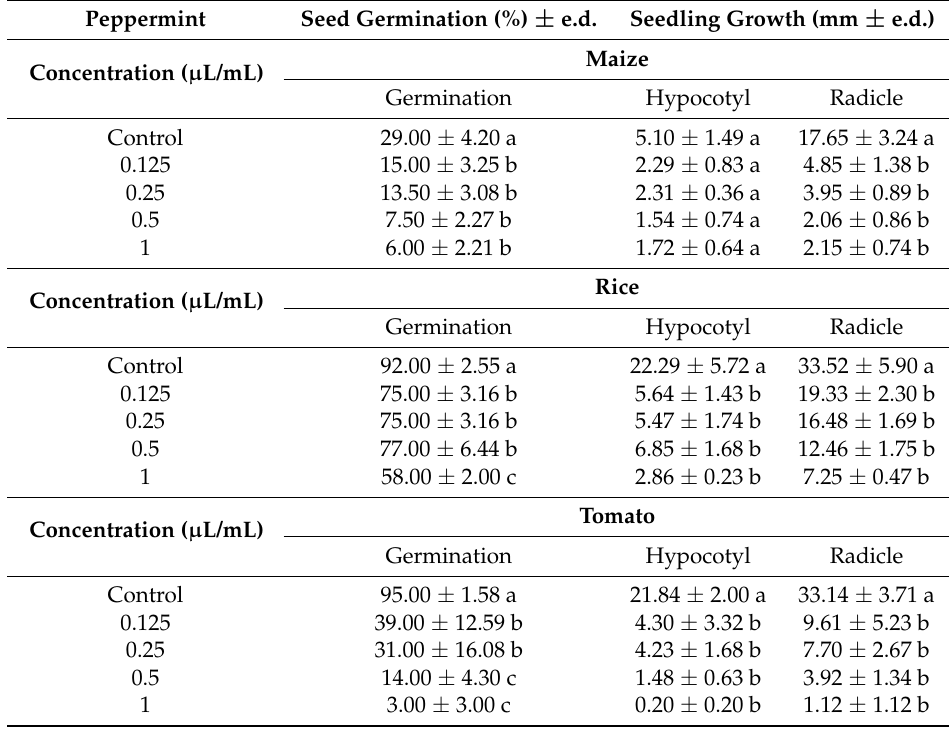
Values are mean of five replications ± error deviation after 14 days of incubation. Means followed by different letters in the same column indicate that they are significantly different at p < 0.05 according to T3 Dunnet